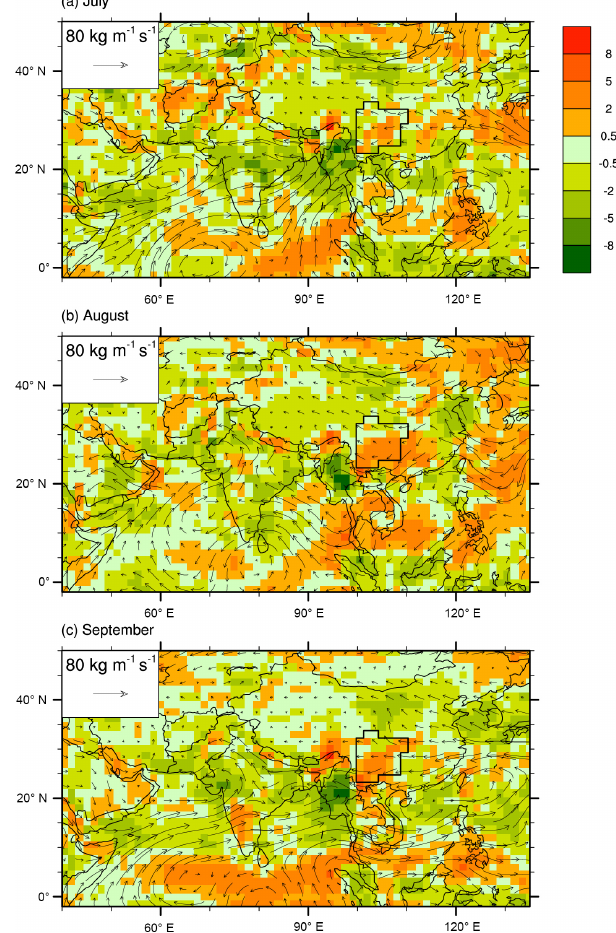
Figure 7. The monthly difference flux (vectors) of the dynamic component of the stationary moisture transport between the last and first 10 years (last–first) and its divergence (unit: 10 − 5 kgm − 2 s − 1 ;